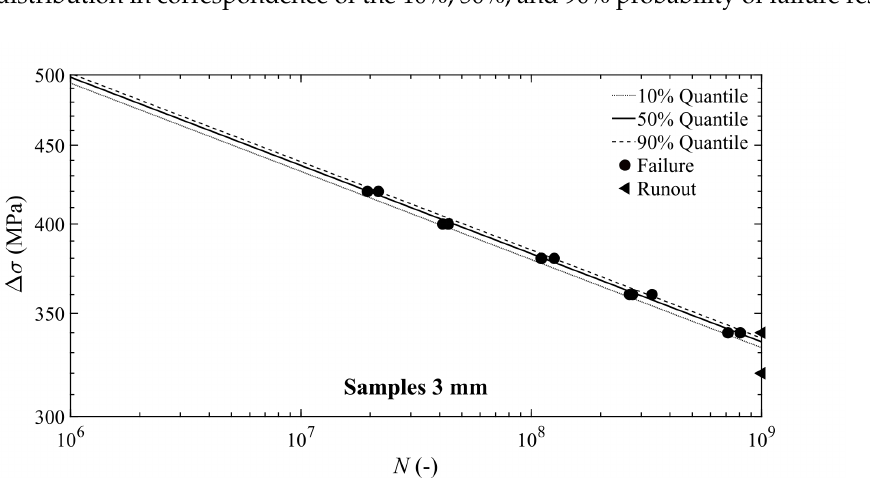
Figure 13. P-S-N curves for the specimens of 3 mm in diameter.